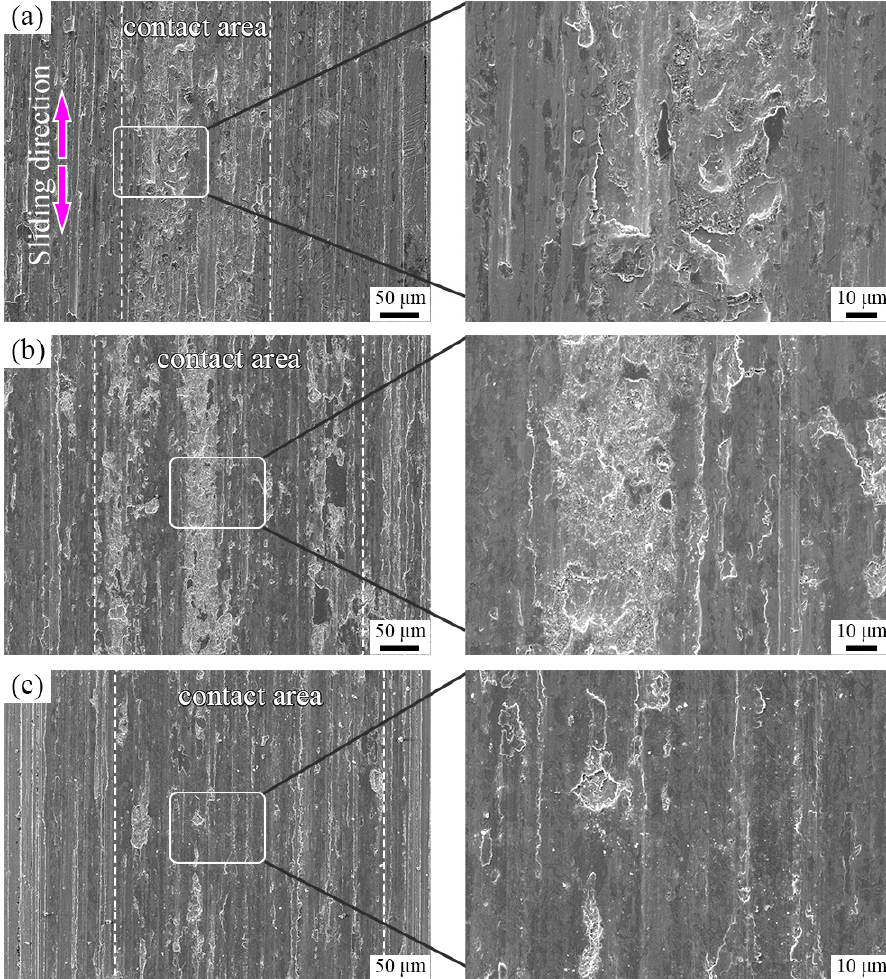
Figure 10. SEM micrographs of wear tracks and corresponding magnified micrographs for QT ( a ), NT ( b ), and ST ( c